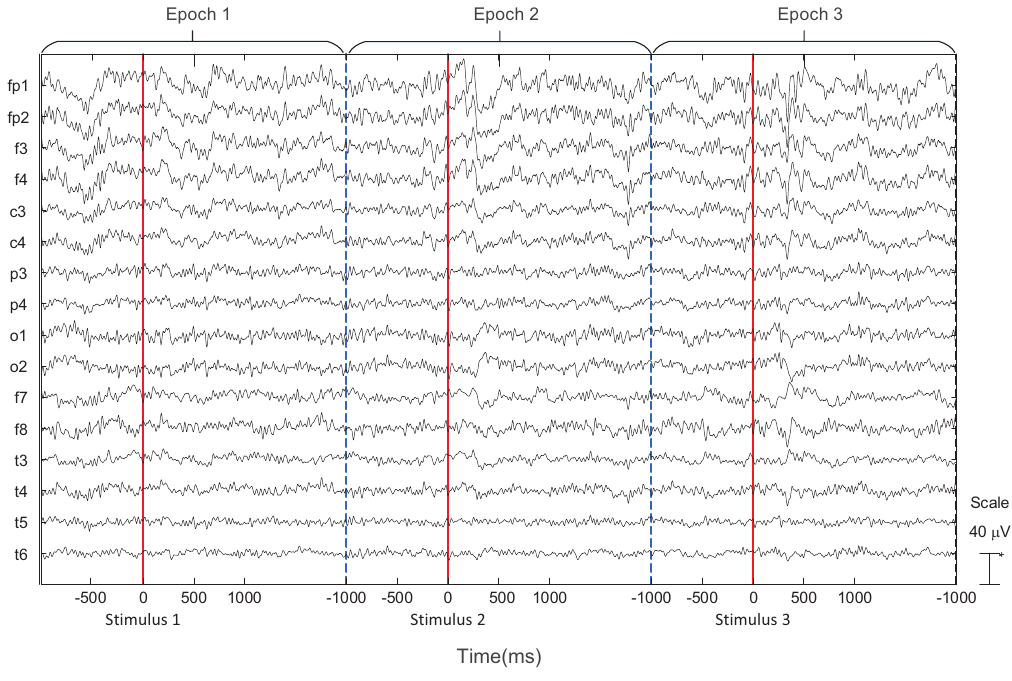
Figure 3. EEG signal collected from one subject after artifact removing. An example consists of 3 epochs during the 1-back task.